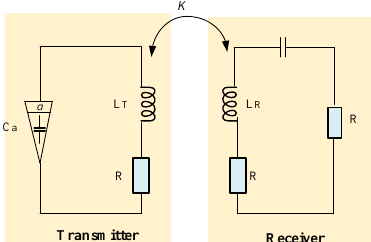
Figure 1. Schematic of the WPT system with fractional-order capacitor ( C a